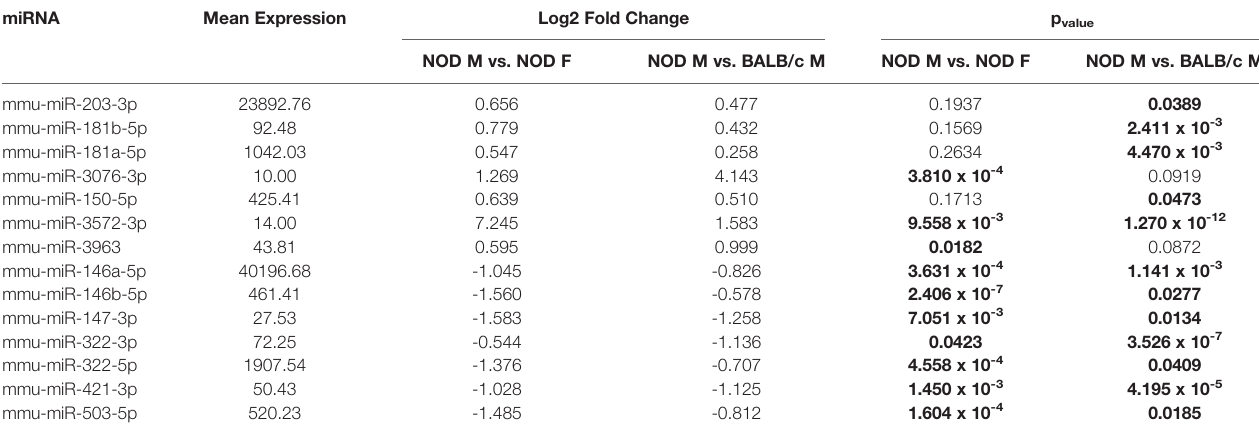
TABLE 1 | Differentially expressed miRNA in male NOD mice tears as compared to those in tears of male BALB/c and female NOD mice. miRNA Mean Expression